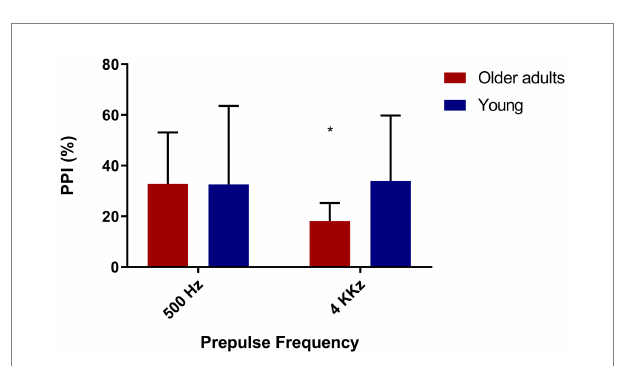
FIGURE 4 Older adults show less inhibition with high frequency prepulse. Older adults ( N = 12), young people ( N = 13). 500 Hz: t = 1.41/ p = 0.17— Mean = 68.25(younger), 53.55 (older). 4,000 Hz: t = 4.44/ p = 0.00— Mean = 62.46 (young), 14.98